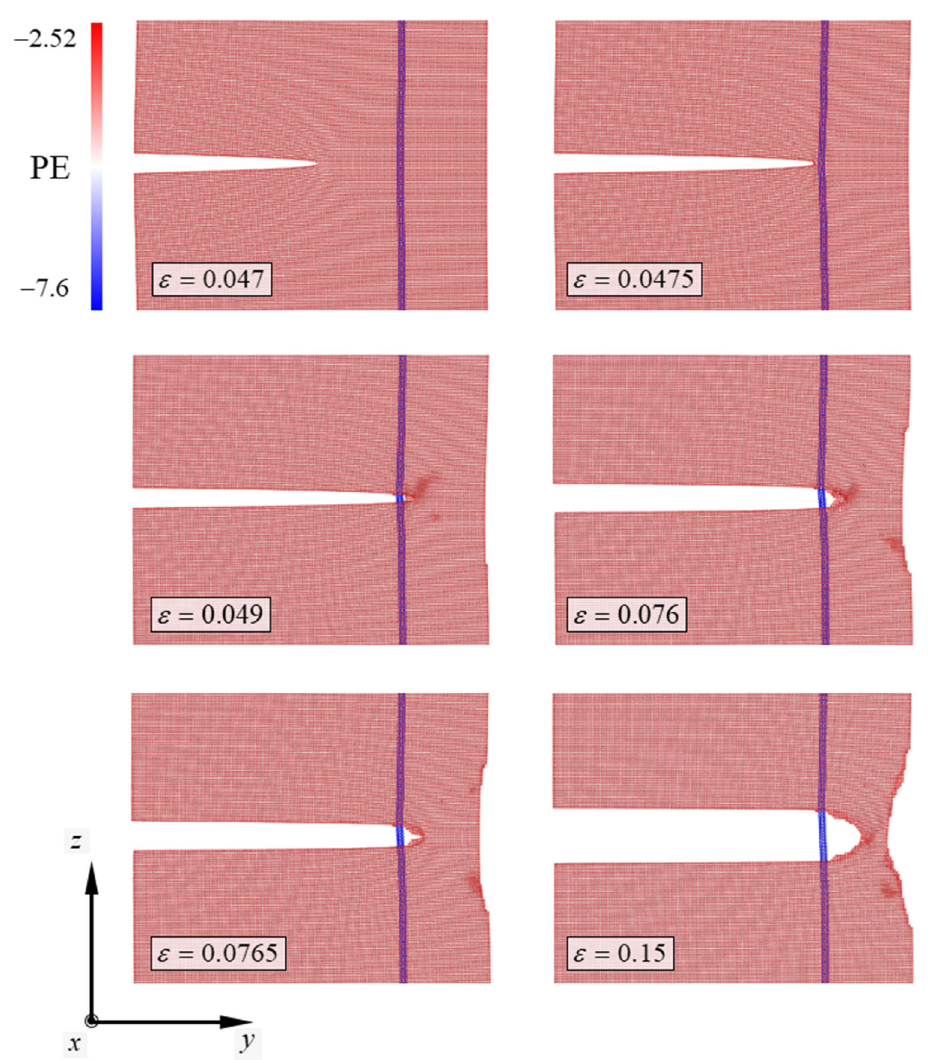
Figure 4. Atomic configurations depicting the deformation mechanism of the Cu/CNT composite containing the (4,4) CNT. PE denotes potential energy of the atom consisting of the simulation model. The numbers next to the color bar denote the range of the PE and SI unit of the PE is eV.